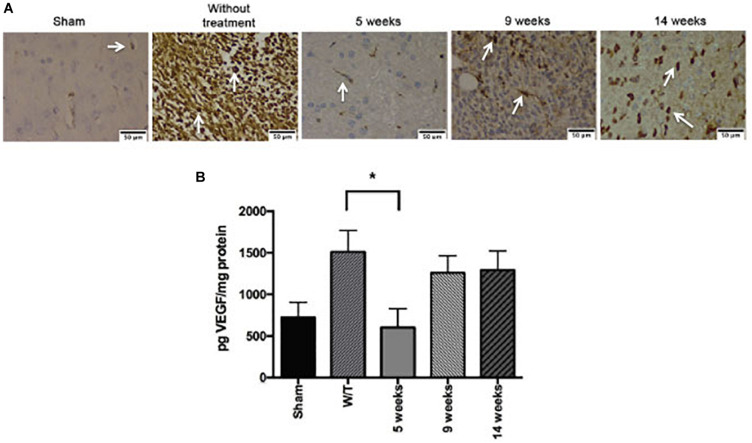
Effect of mifepristone/temozolomide on VEGF during tumor recurrence. (A) Immunohistochemical stainings with CD31 marker. Vessel density was assessed by immunostaining for CD31 positive glioma cell nuclei in rats implanted with glioma. The images are representative of three animals per treatment. Scale bar 50 μm. (B) Expression of VEGF in the sham-operated rats, implant-operated animals with no drug treatment (W/T), and at 5, 9 and 14 weeks post-surgery (the mifepristone/temozolomide (Mif/Tz) treatment were given only during weeks 2–5). Compared to the W/T rats, the Mif/Tz animals showed a lower level of VEGF at 5 weeks and a similar level at the time of tumour recurrence, at 9 and 14 weeks post-surgery. Data are expressed as the mean ± SD from five independent experiments. * Significant difference (p < 0.05) between the Mif/Tz and W/T group.